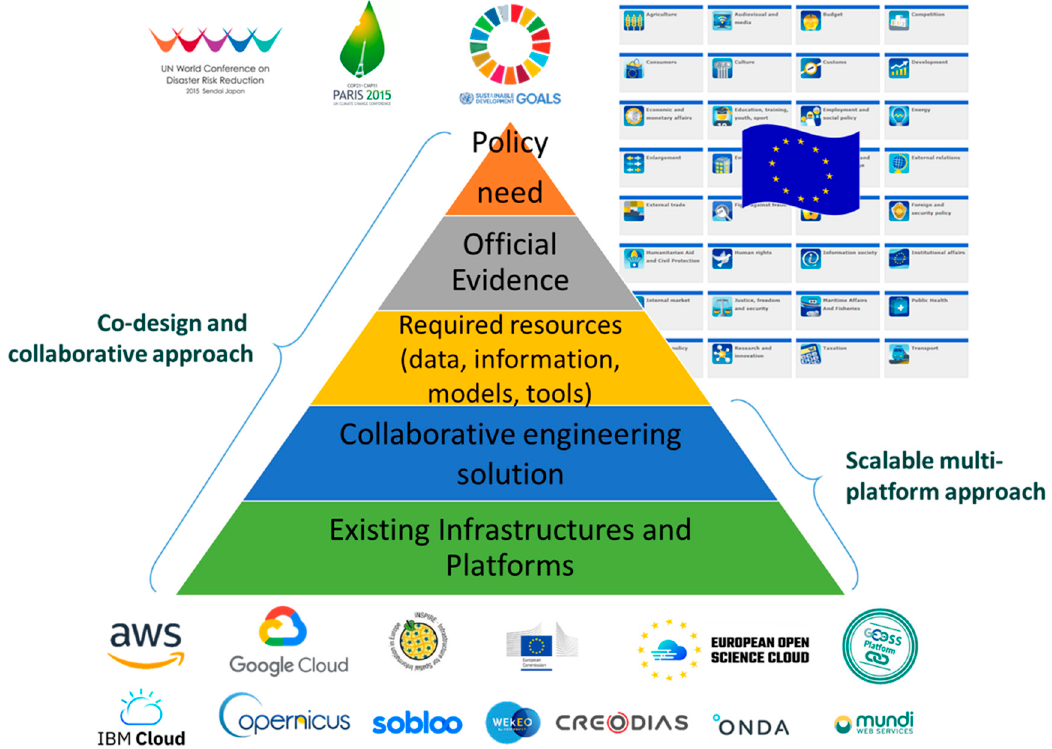
Figure 2. Approaches and components for designing and implementing applications for policy- makers.